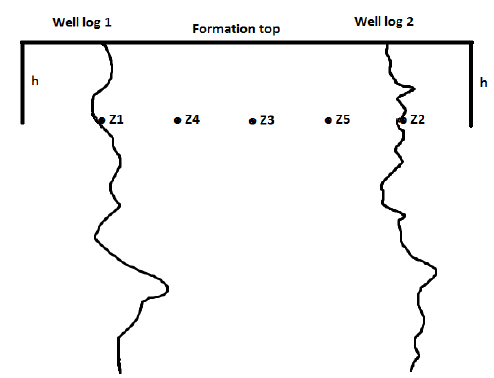
21 Fig. 3. Fractal behavior for the VSH traces, applying Rescaled- Fig. 4. Fractal interpolation process between two Fig. 4. Fractal interpolation process between two wells.